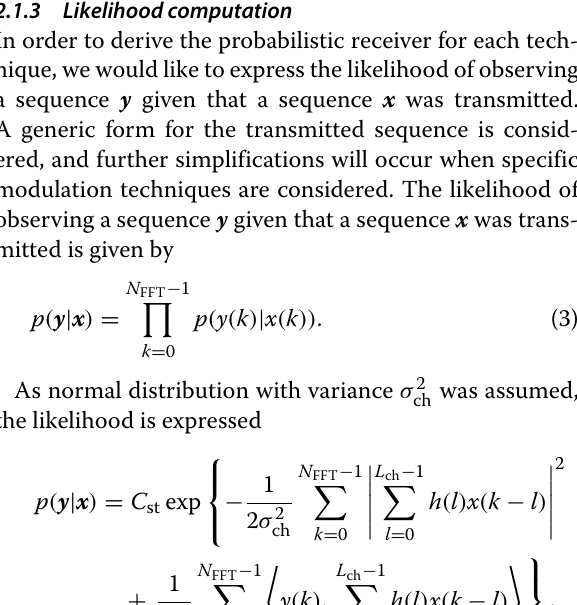
Fig. 1 System model for the OFDM framework